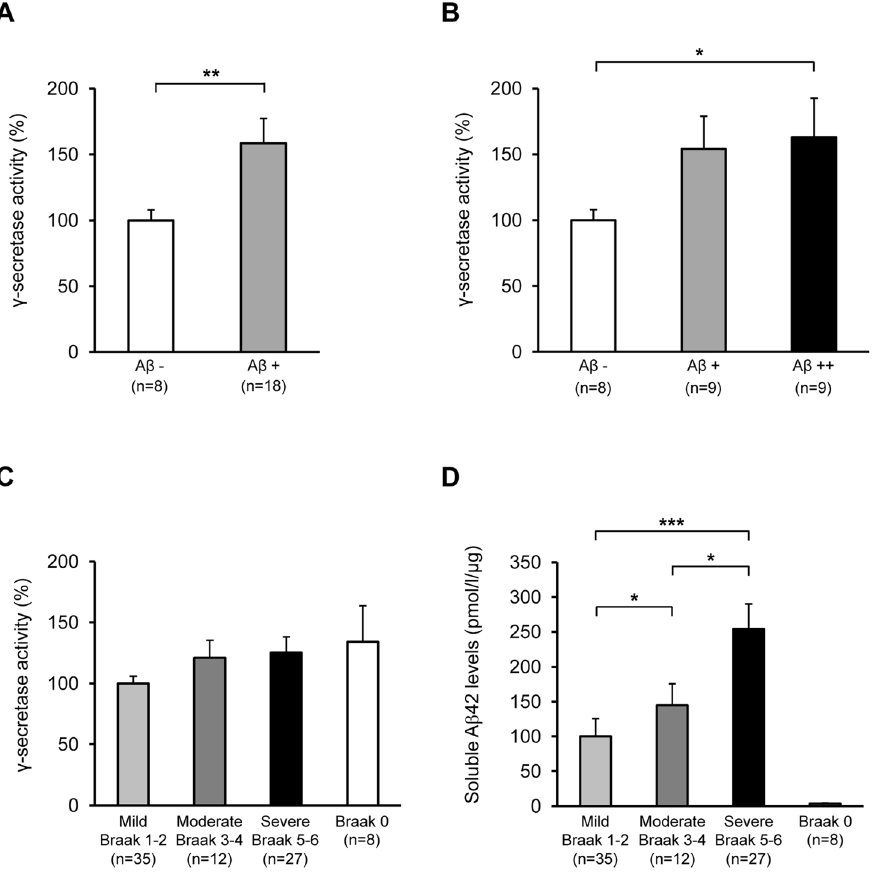
Figure 2. c -secretase activity is increased in the frontal cortex of iNPH patients with A b 2 pathology. (A) Visual plaque count from immunostained brain sections: A b 2 =no plaques, A b + = plaques observed. Significant increase in c -secretase activity is observed in A b + samples compared to A b - samples. (B) A b 2 =no plaques, A b + = less than 100 plaques and A b ++ = more than 100 plaques per section. Increase in c - secretase activity (not significant) can be observed along with increased A b 2 status. (C, D) Significant increase is observed in soluble A b 42 levels but not in c -secretase activity in the inferior temporal cortex of AD patients in relation to disease pathology (Braak 0= subjects without neurofibrillary pathology, 1–2=mild, 3–4=moderate, and 5–6=severe). Mild AD group was normalized to 100%. Soluble A b 42 levels in Braak 0 group were significantly decreased when compared to mild, moderate and severe groups ( p , 0.05). Data are shown as mean 6 SE, *** p , 0.001, ** p , 0.01, * p ,